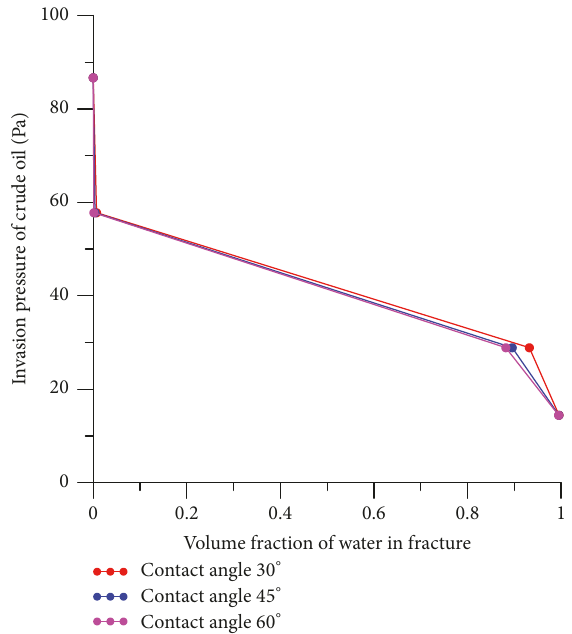
Figure 12: Relationship between the invasion pressure of crude oil and volume fraction of water in the fracture for different contact angles at time 15s (FD =